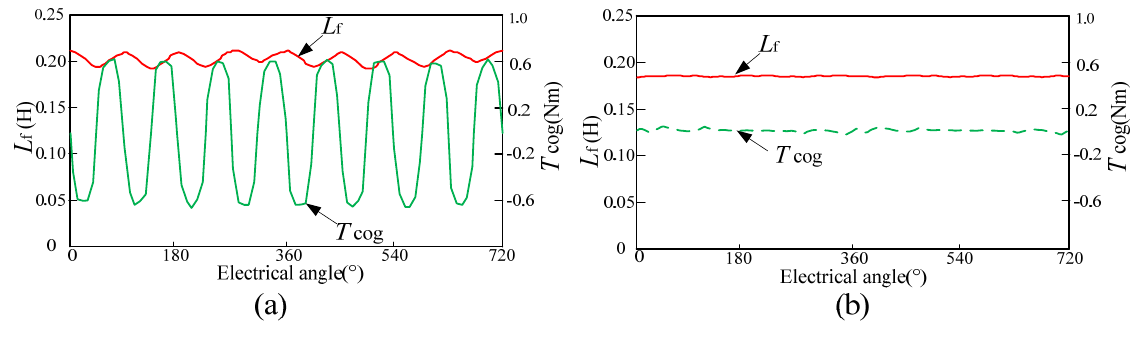
Figure 5. L f of the four-phase WFDSM. ( a ) α s = 0.5; ( b ) α s =